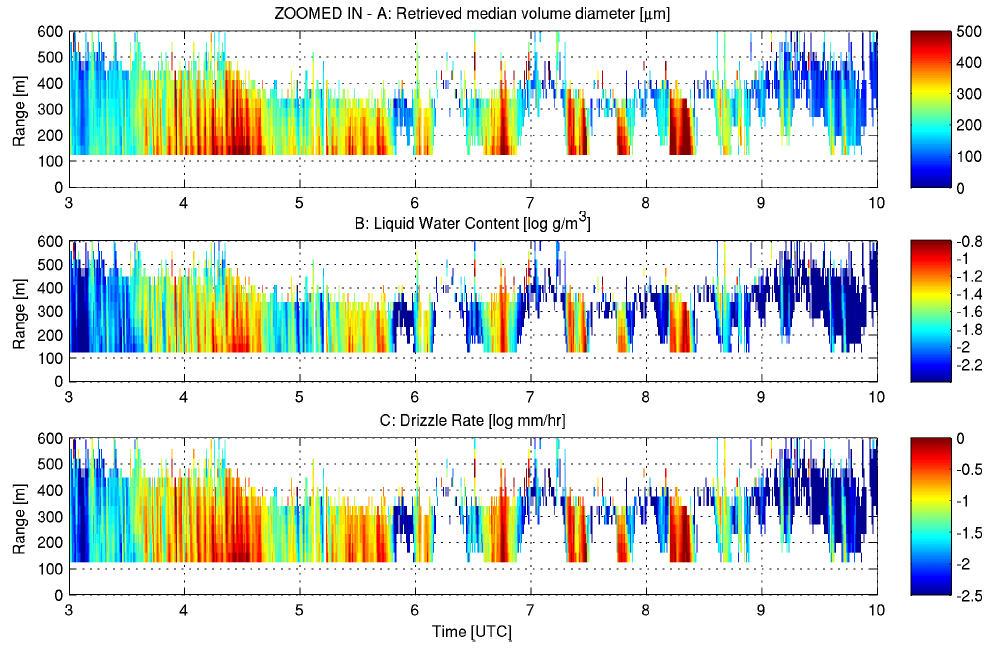
Fig. 10. Lidar-retrieved drizzle drop size (A) , liquid water content (B) and precipitation rate (C) for case II: 14 December 2006. Note that the range axis is zoomed-in relative to Fig. 9 to provide a better view of the retrieved drizzle parameters below cloud base.